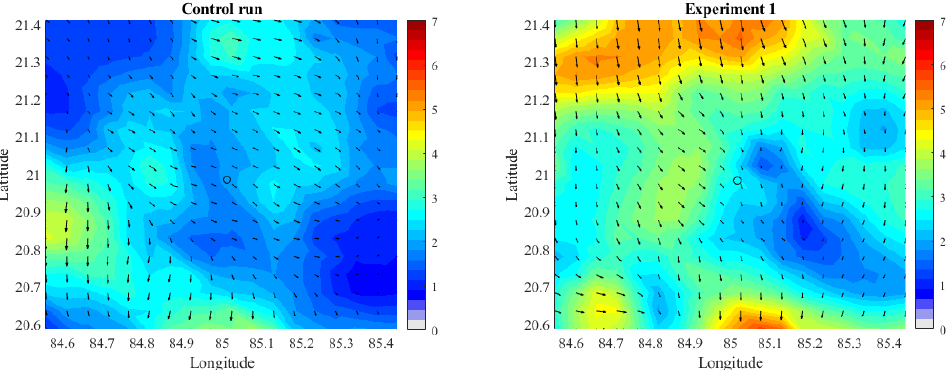
Figure 9. Flow pattern comparisons on 22 March 2008 for WDM6 at near-surface level .